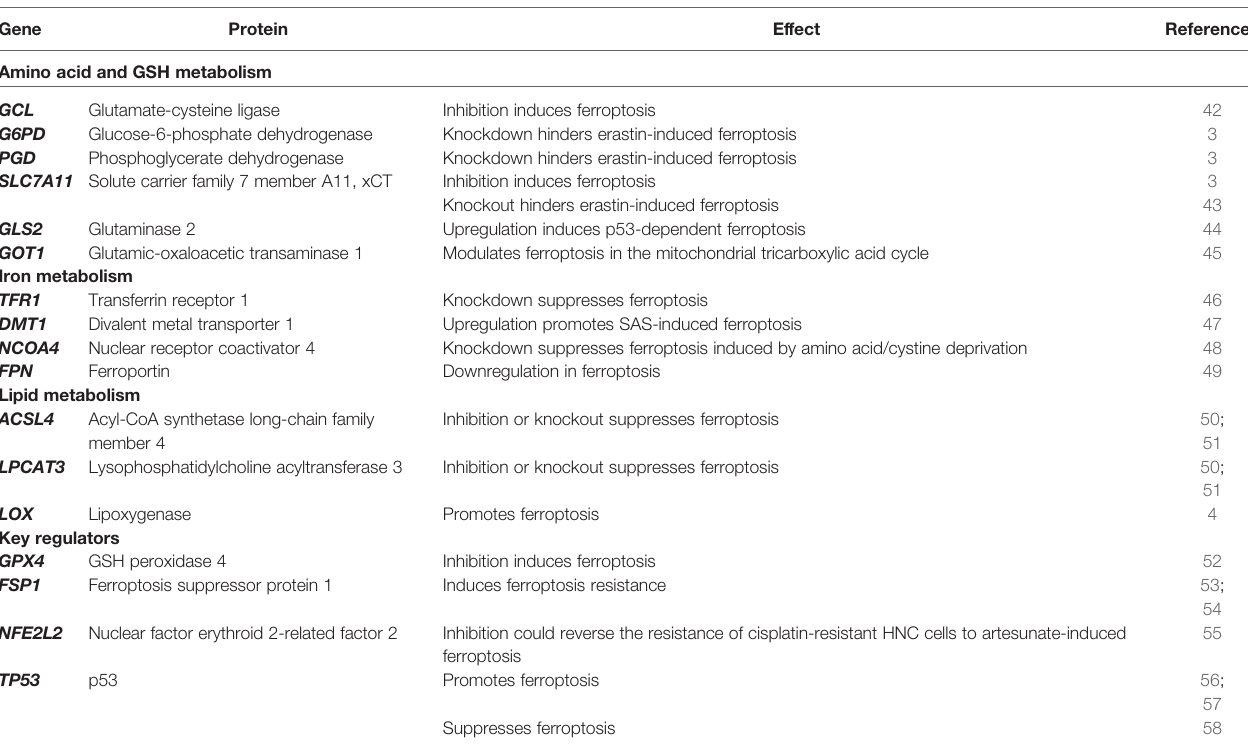
TABLE 1 | Regulators of